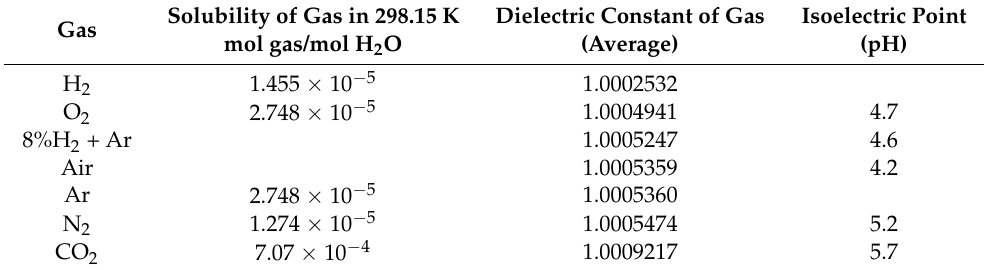
Figure 2. Zeta potential of N 2 , O 2 , Ar + 8%H 2 and CO 2 nanobubbles in deionized water as a function of pH. Table 1. Solubility of gas, dielectric constant [37] and isoelectric point of nanobubbles determined from the results shown in Figure 1.